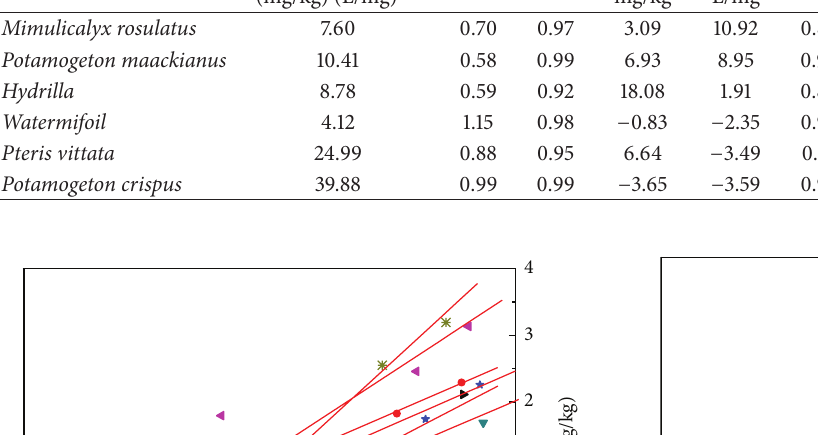
Table 1: Isotherm parameters for Langmuir, Freundlich, and Dubinin-Radushkevich models for As (III) adsorption at 13 ∘ C. Plants